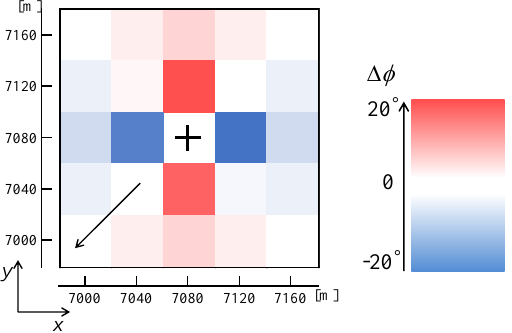
Figure 6. Color-coded azimuth error (in degrees) due to the presence of a nearby conducting structure having a height of 60 m and a square cross-section of 40 m × 40 m for the case of true azimuth φ equal to 45 ° . Each small square, except for the one in the center, represents the position of conducting structure, with the total number of such positions being 24. The large plus sign in the center ‘+’ indicates the location of observation point, and the arrow indicates the true direction to lightning. Table 1. FDTD-computed peak values of H x and H y , and azimuth errors estimated from Equation (2) for the case of true azimuth φ equal to 45 ˝ and current risetime equal to 1 µ s. Position of Structure Center H x